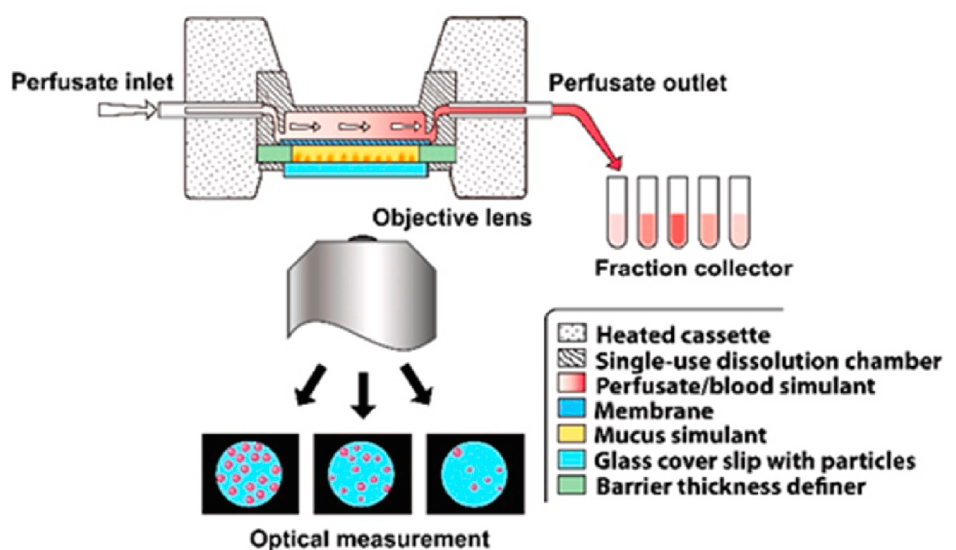
® (the figure was taken from reference Figure 9. An overview of Dissolvit ® (the fi gure was taken from reference [21]). Figure 9. An overview of Dissolvit